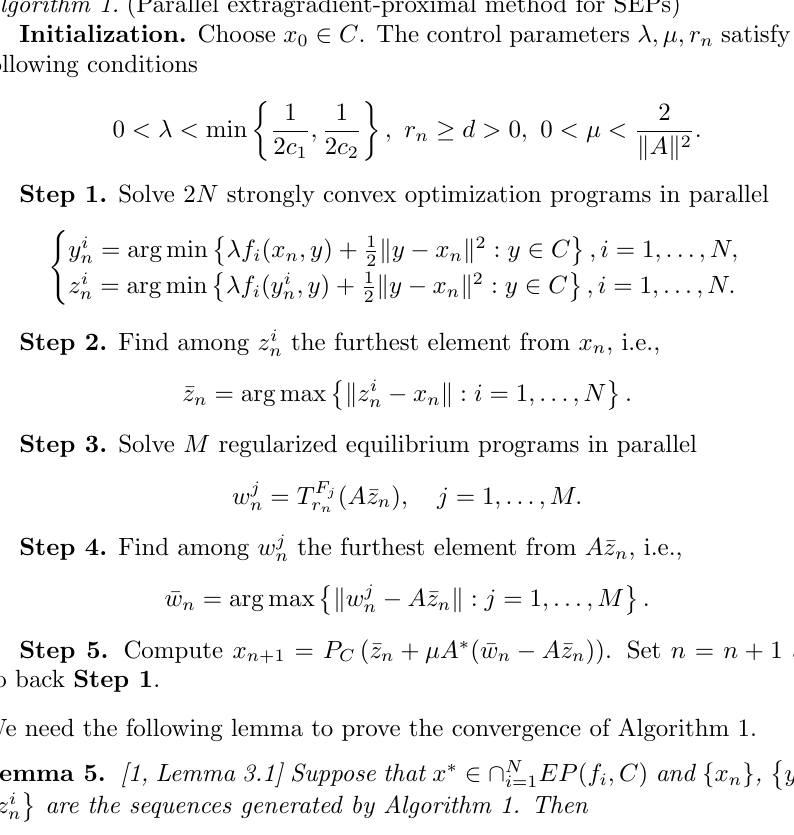
Algorithm 1. (Parallel extragradient-proximal method for